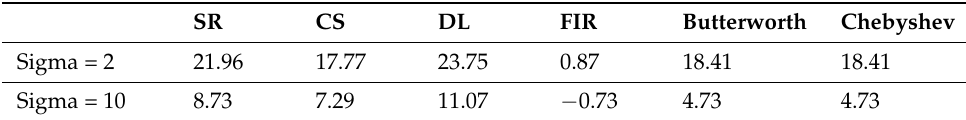
Table 3. Comparison of